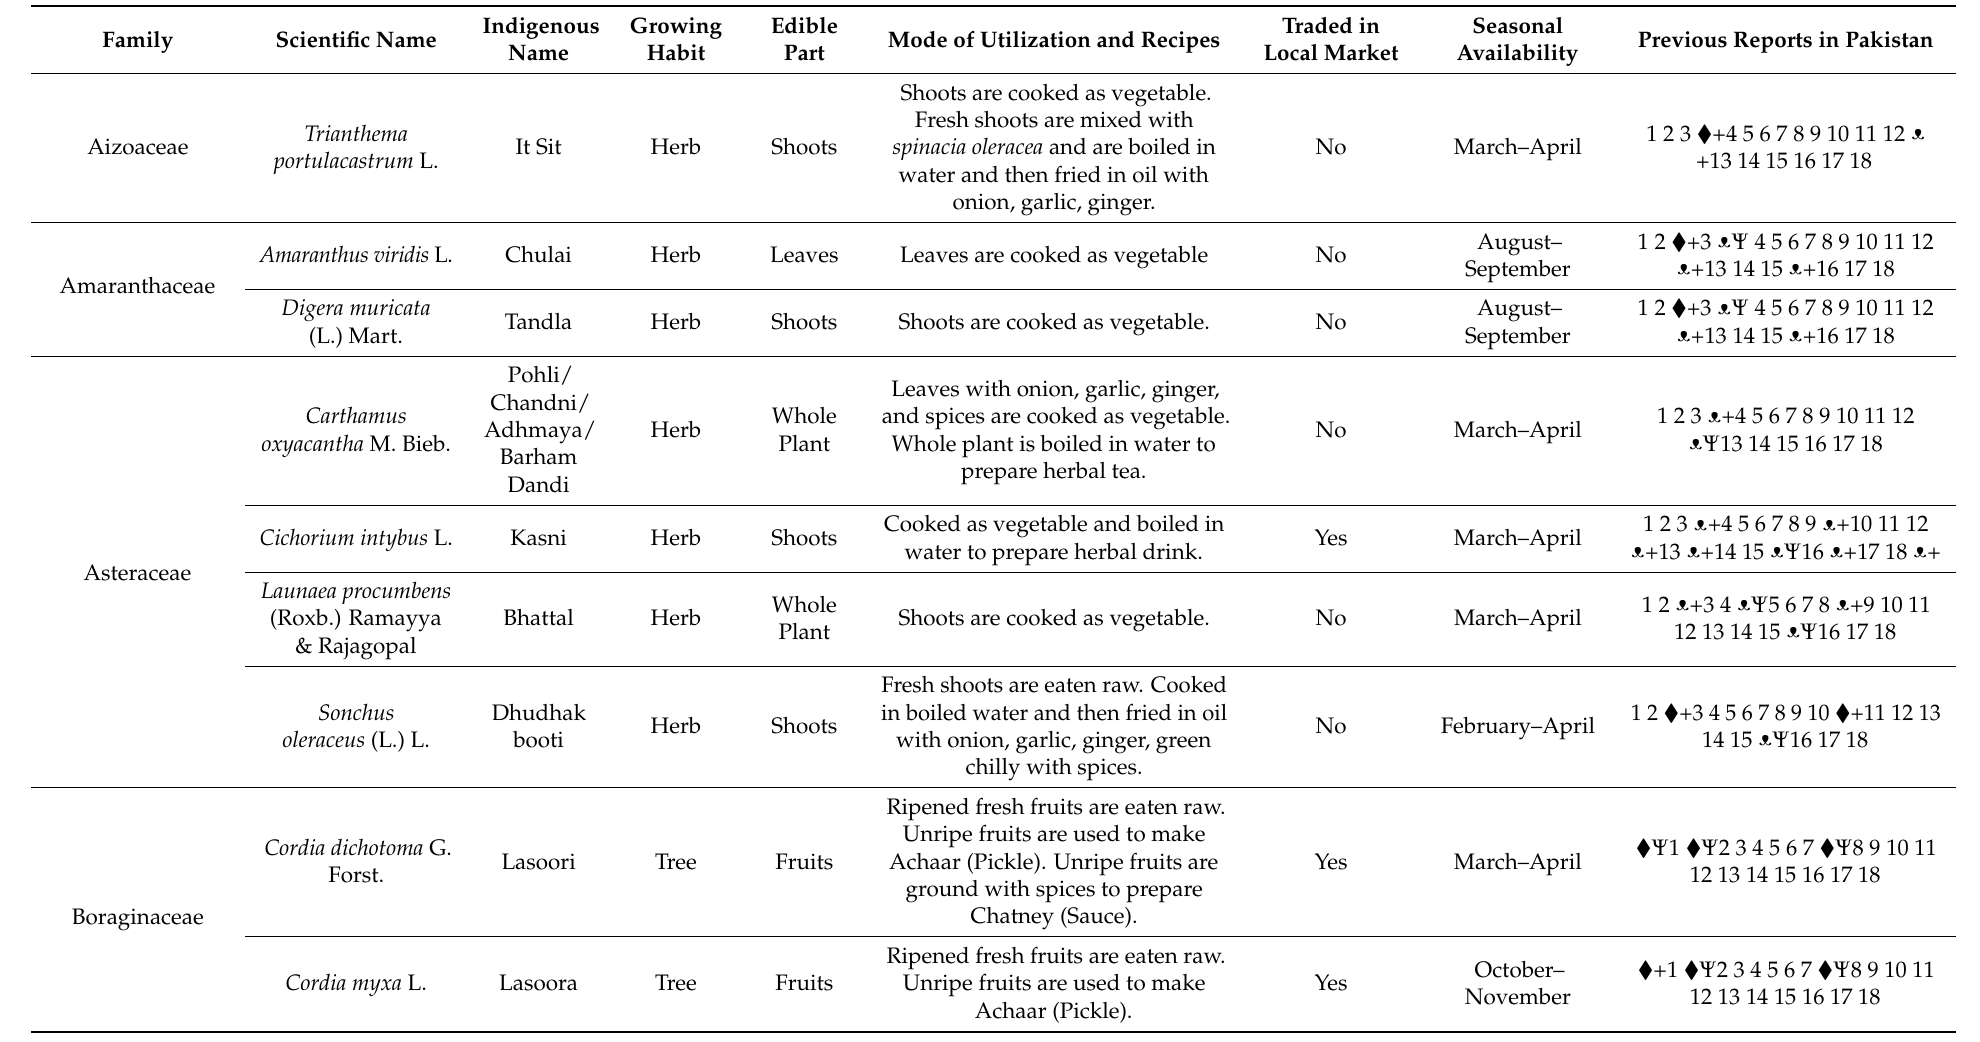
Table 2. Wild edible food plants based on nutritional values and economic uses by natives Pipli Pahar from the Indo–Pak border in Pakistan.